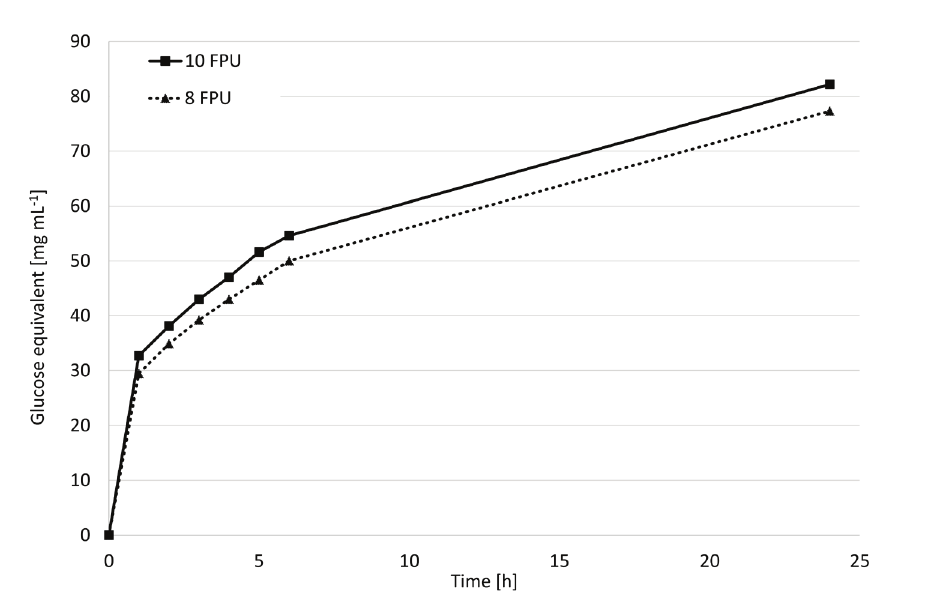
Fig. 10 – Conversion of 15 % α-cellulose at 10 FPU and 8 FPU enzyme input (15 % SL; α-cellulose, 2.05 Hz, 10 mm amplitude, 3 mm baffle, 50 °C, 24